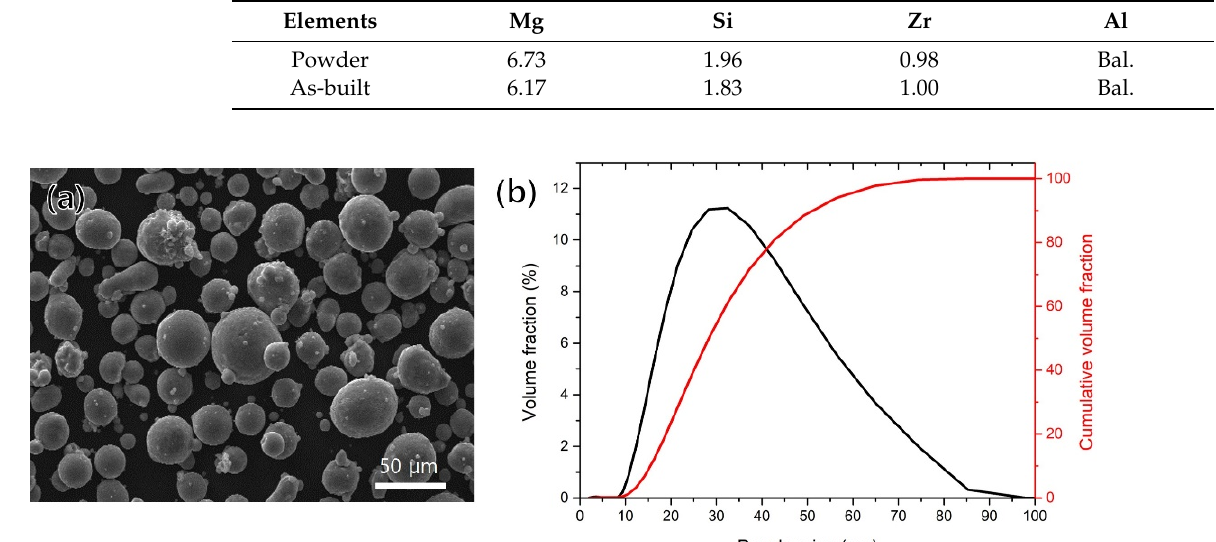
Table 2. The chemical composition of the powder and as-built specimens.